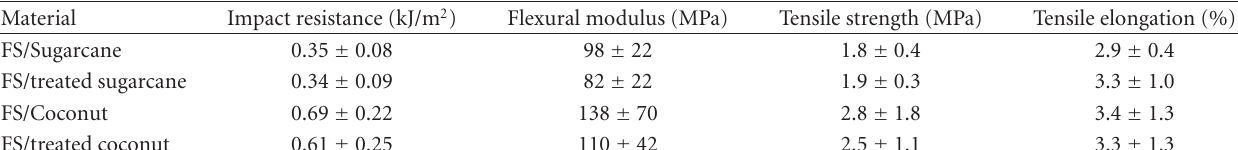
Table 10: Impact, flexural, and tensile properties for biocomposites foams (54 RH%).